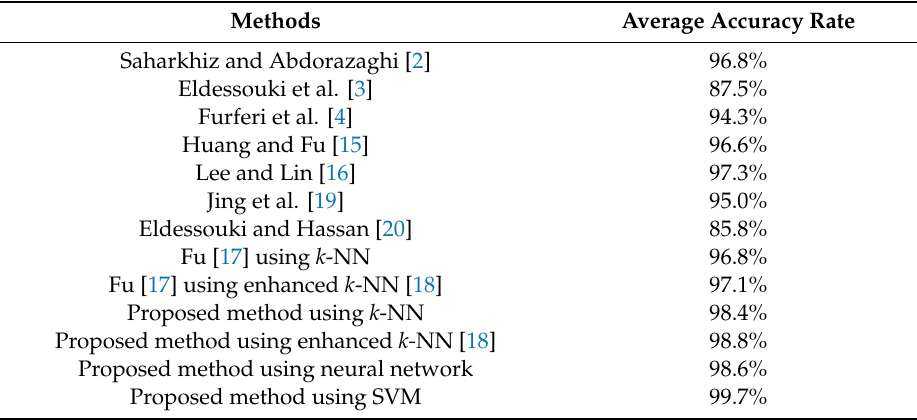
Table 5. Comparison of the results of other pilling evaluation